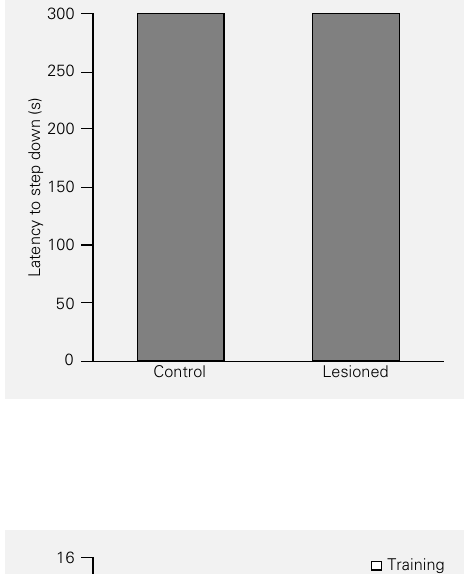
Figure 4 - Effect of a pretraining lesion of the entorhinal cortex on performance in an open field task. Data are reported as means ± SEM (N = 10 animals/ group). There were no significant differ- ences between groups (P>0.05, Student t -test). *P<0.05 com- pared to the training session (paired Student t -test).